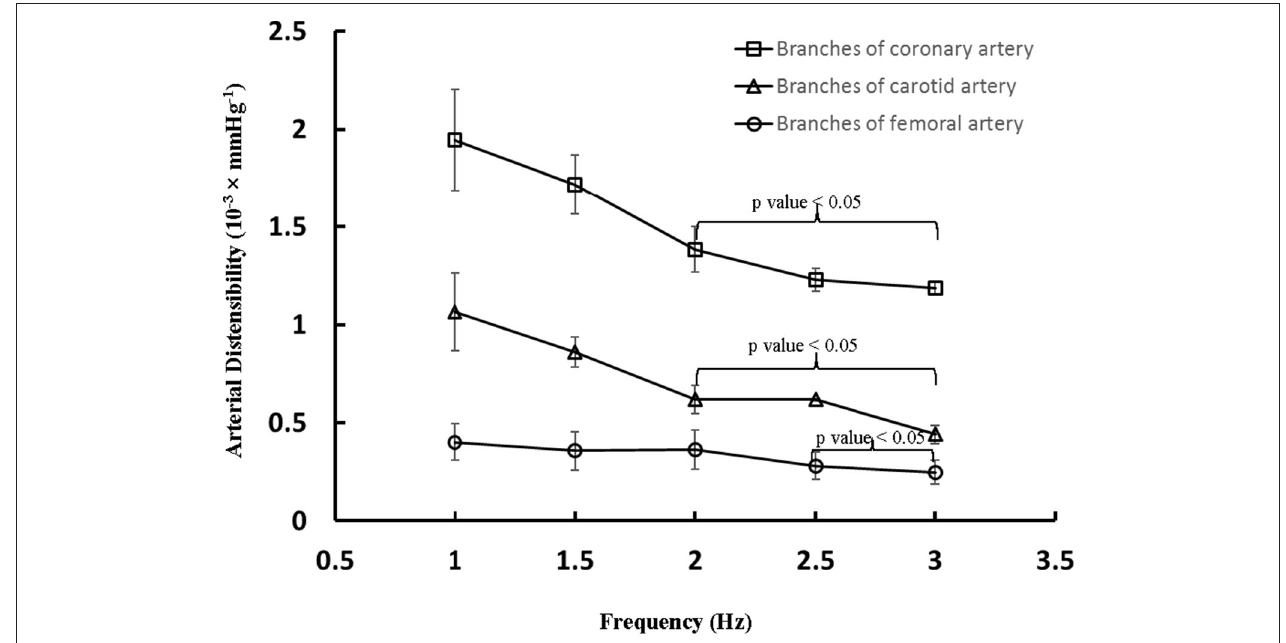
FIGURE 3 | Arterial distensibility (Unit: 10 − 3 × mmHg − 1 ) as a function of frequency in isolated small branches of coronary, carotid or femoral arteries. There is statistically significant difference ( p < 0.05) in arterial distensibility between 1.5Hz (mimicking the HR of 90 bpm) and higher frequencies in parentheses (i.e., ≥ 2Hz in branches of coronary and carotid artery and ≥ 2.5Hz in branches of femoral artery).